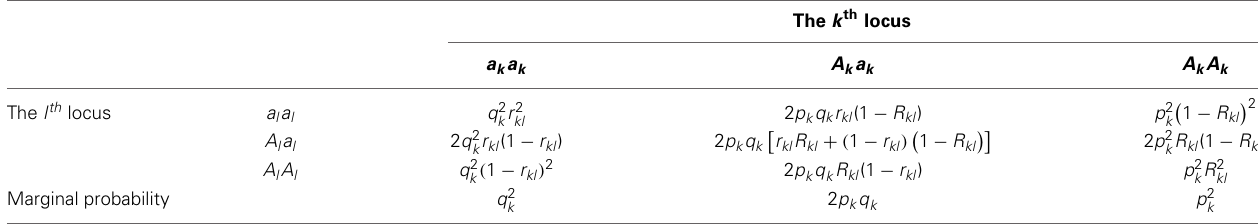
Table 2 | The joint distribution of two